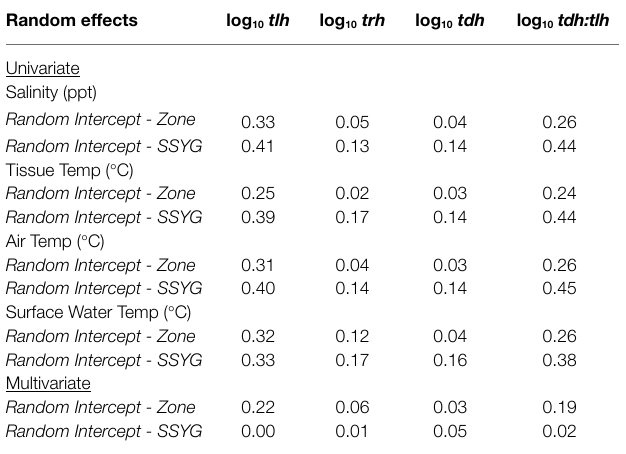
TABLE 3 | Univariate and multivariate associations between the tdh:tlh ratio with environmental covariates.